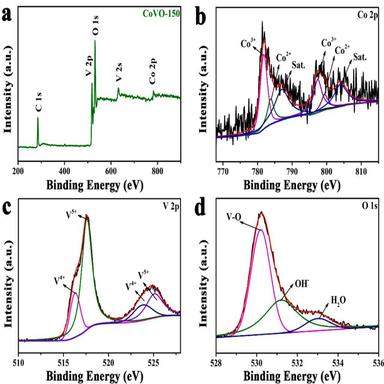
(a) Full survey XPS spectrum of CoVO-150. High-resolution XPS spectra of (b) Co 2p, (c) V 2p, and (d) O 1 s of CoVO-150.